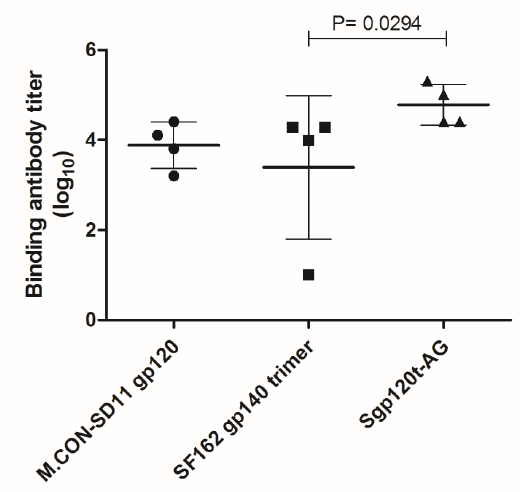
Figure 5. Evolution of the binding IgG reactivity in sera of immunized rabbits against heterologous protein HIV-1 group M consensus gp120 envelope (M. CON-S D11). Animals R5 – 8 (Group 3) were primed with VVgp120t-AG and boosted with Sgp120t-AG. Priming was administered at day 1 and boosts I, II, and III at days 35, 63, and 121, respectively. *Animals R6 and R8 received an extra boost at day 150 (boost IV). All animals were sacrificed at day 154 (T5). Cut-off value was calculated as the mean OD of rabbits immunized with VV WR immunogens (control Group 2) plus four times the standard deviation. OD/cut-off ≥1 was considered positive and is defined by the dashed line.